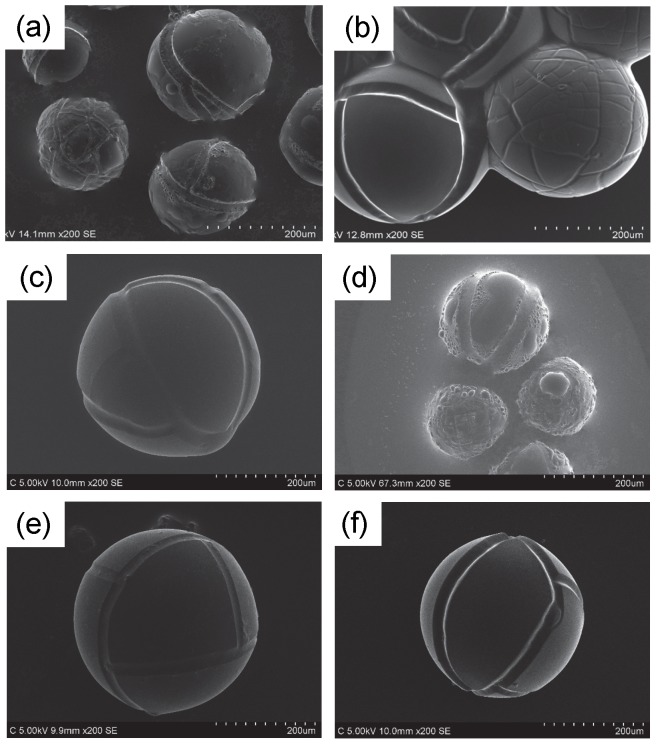
SEM images of hydrous SAP particles pretreated with different neat RTILs.(a) [C2mim][BF4]; (b) [C2mim][AcO]; (c) [C2mim][Lac]; (d) [C4mim][BF4]; (e) [Ch][Lac]; (f) [P4, 4, 4, 1][DMP].